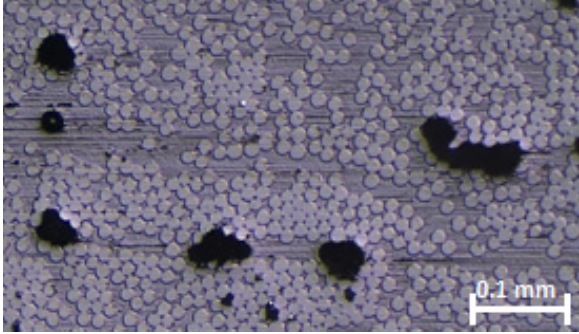
Figure 6: Detailed microscopy showing individual fibers.